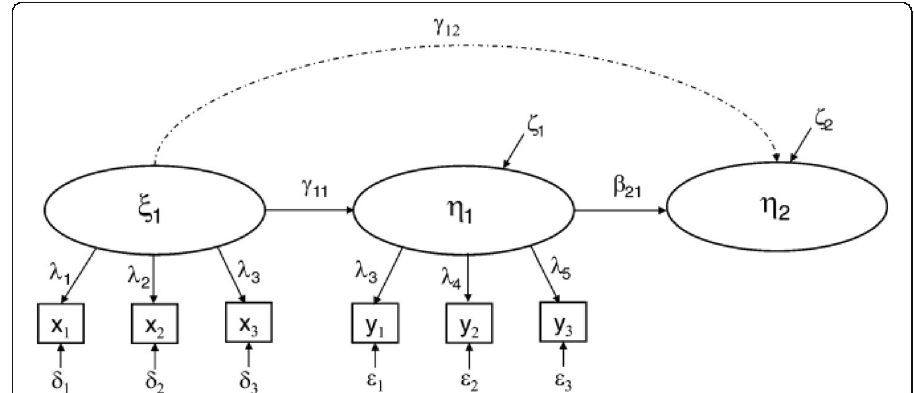
Fig. 2 Illustration of SEM diagram showing the addition of a direct effect in the model. Source: Catherine et al.